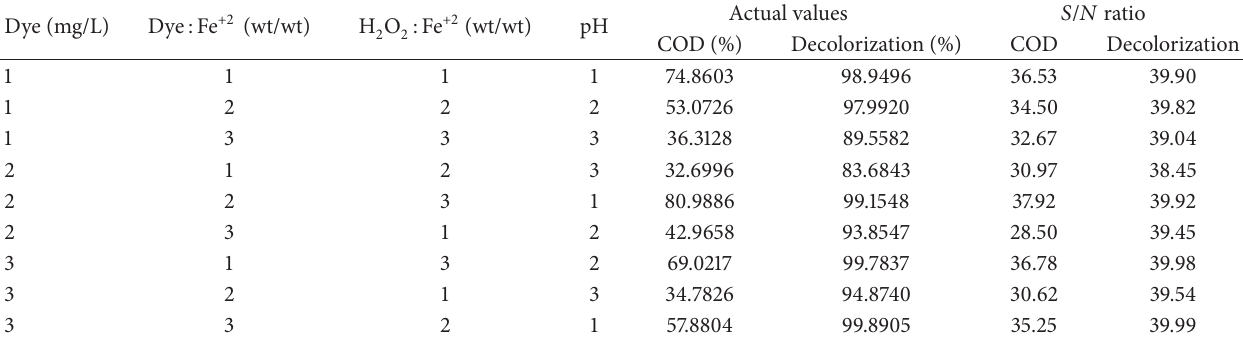
Table 7: 𝐿 9 orthogonal designs, Levels of four factors, and experimental results obtained.